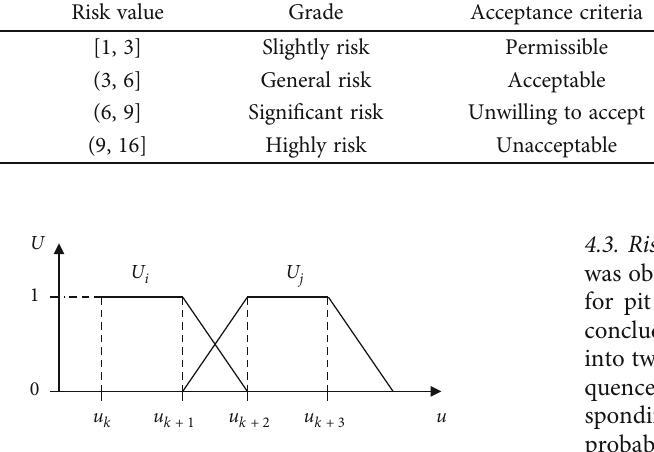
Figure 2: General form of trapezoidal membership